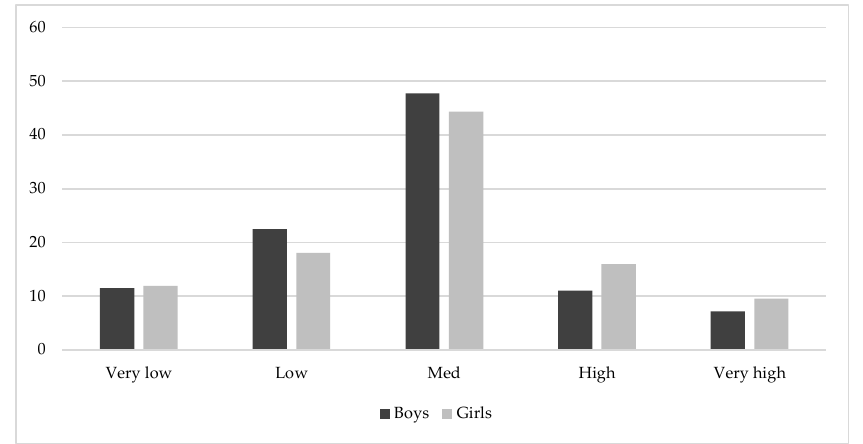
Figure 3. Proportion of boys and girls in each of the Alpha Fitness categories based on the percentage of body fat.